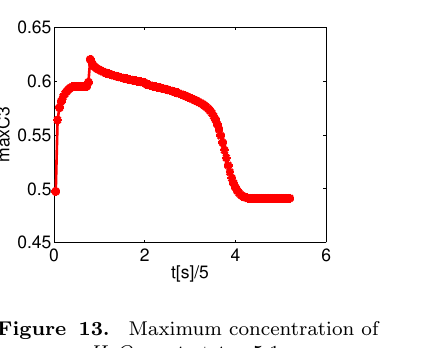
Figure 13. Maximum concentration of H 2 O vs. t at t f =5.1.